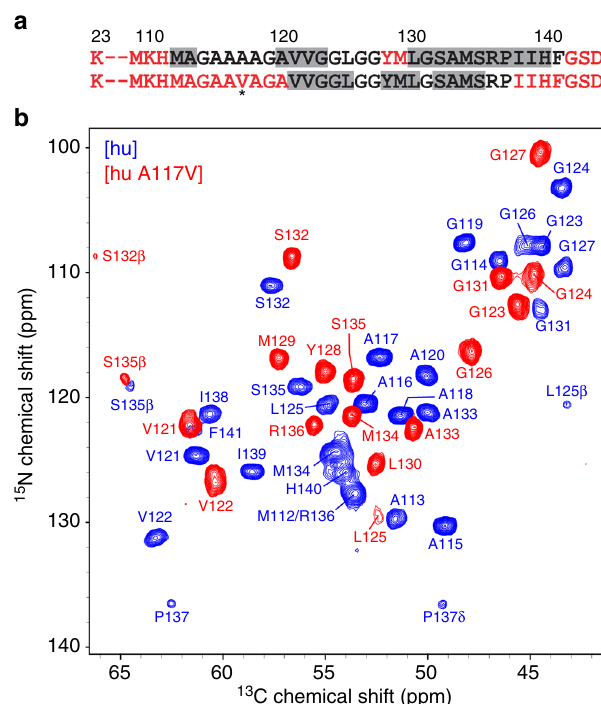
Fig. 3 Two-dimensional 15 N – 13 C α solid-state NMR spectrum of amyloid fi brils formed by the A117V mutant of human PrP23-144. a Amino acid sequences of huPrP23-144 and huPrP23-144 A117V, with the mutation site indicated by an asterisk . Immobile residues located within the amyloid core and conformationally fl exible residues are shown in black and red fonts , respectively. Residues with the highest β -strand propensity based on TALOS-N 41 analysis are indicated by gray rectangles (c.f., Fig. 1 and Supplementary Fig. 5). b Assigned two-dimensional 15 N – 13 C α fi ngerprint solid-state NMR spectrum of [hu A117V] amyloid fi brils ( red contours ), overlaid with the corresponding spectrum of [hu] amyloid ( blue contours